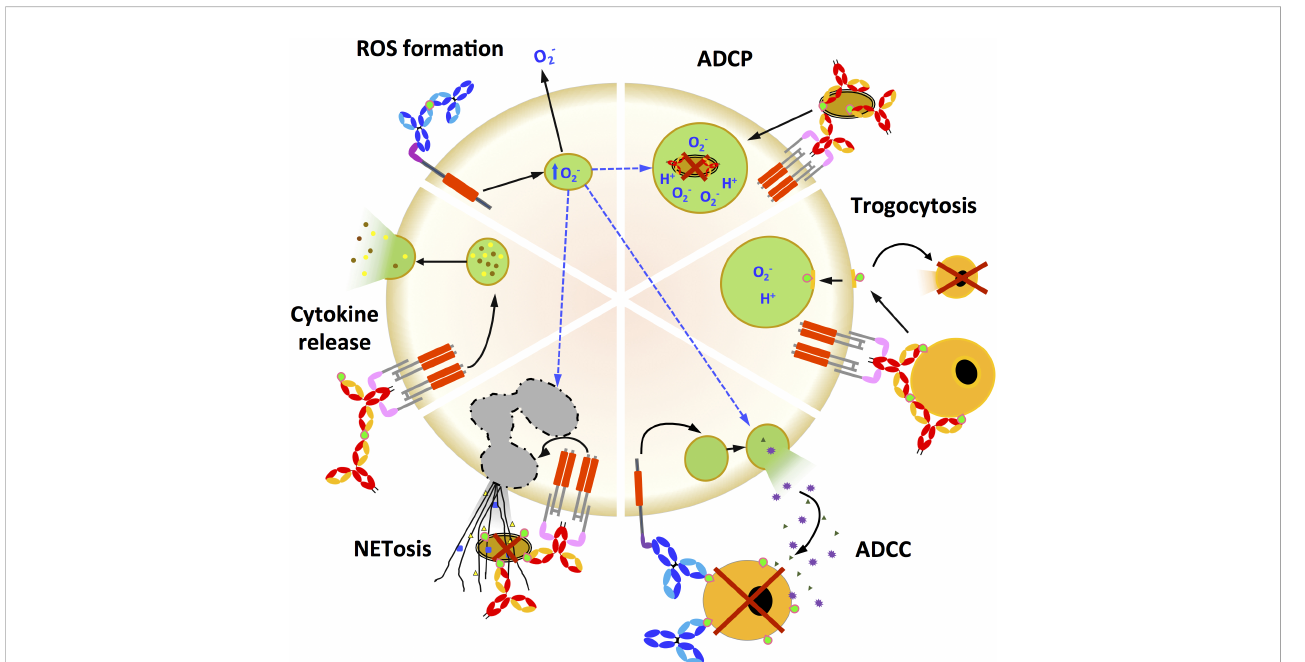
FIGURE 3 Fc-dependent effector functions triggered by FcR activation. Fc-mediated functions (ADCP, trogocytosis, ADCC, NET formation, cytokine release and ROS formation) initiated by either IgG (light and dark blue) or IgA (red and yellow) engagement with the cognate FcR that activates ITAM. IgA and IgG immune complex antigens are in green. ADCP : Antibody-dependent cellular phagocytosis is a potent mechanism for eliminating Ab-coated pathogens or tumour cells. Engagement of Fc g R or Fc a RI/CD89 expressed on innate effector cells triggers a signalling cascade leading to engulfment of the pathogen by Ab. ADCC : Antibody-dependent cellular cytotoxicity is a mechanism by which FcR-expressing effector cells recognise, phagocytose and kill Ab-sponsored target cells. Trogocytosis : It is the rapid intercellular transfer of membrane fragments and their associated molecules during intercellular contact. Trogocytosis is typically mediated by the interaction of Fc-FcRs on effector cells with opsonised target cells. Ab-dependent trogocytosis of cancer cells by neutrophils and macrophages can result in target cell death (trogocytosis-mediated cell death). NETosis : Neutrophil-mediated target cell death after initiation by Abs is characterised by the secretion of large neutrophil extracellular traps (NETs) that capture and destroy target cells. Cytokine secretion : Cross-linking of FcRs by immune complexes can induce cytokine release from innate effector cells. The type of cytokine released depends on the type of FcR stimulated. ROS formation : Reactive oxygen species (ROS) induced by FcR cross-linking contribute to a variety of effects such as in ADCP, ADCC and